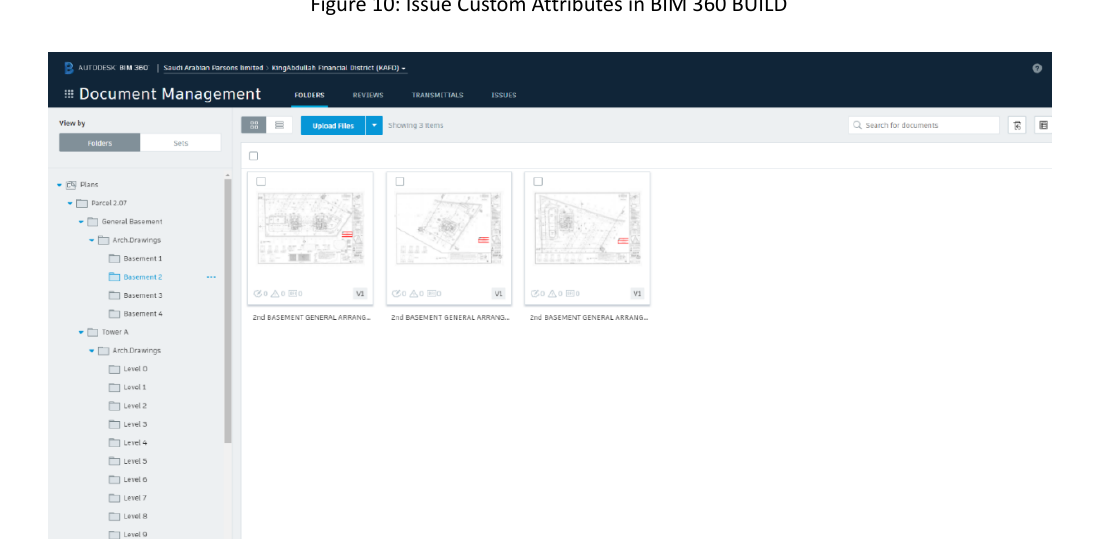
Figure 10: Issue Custom Attributes in BIM 360